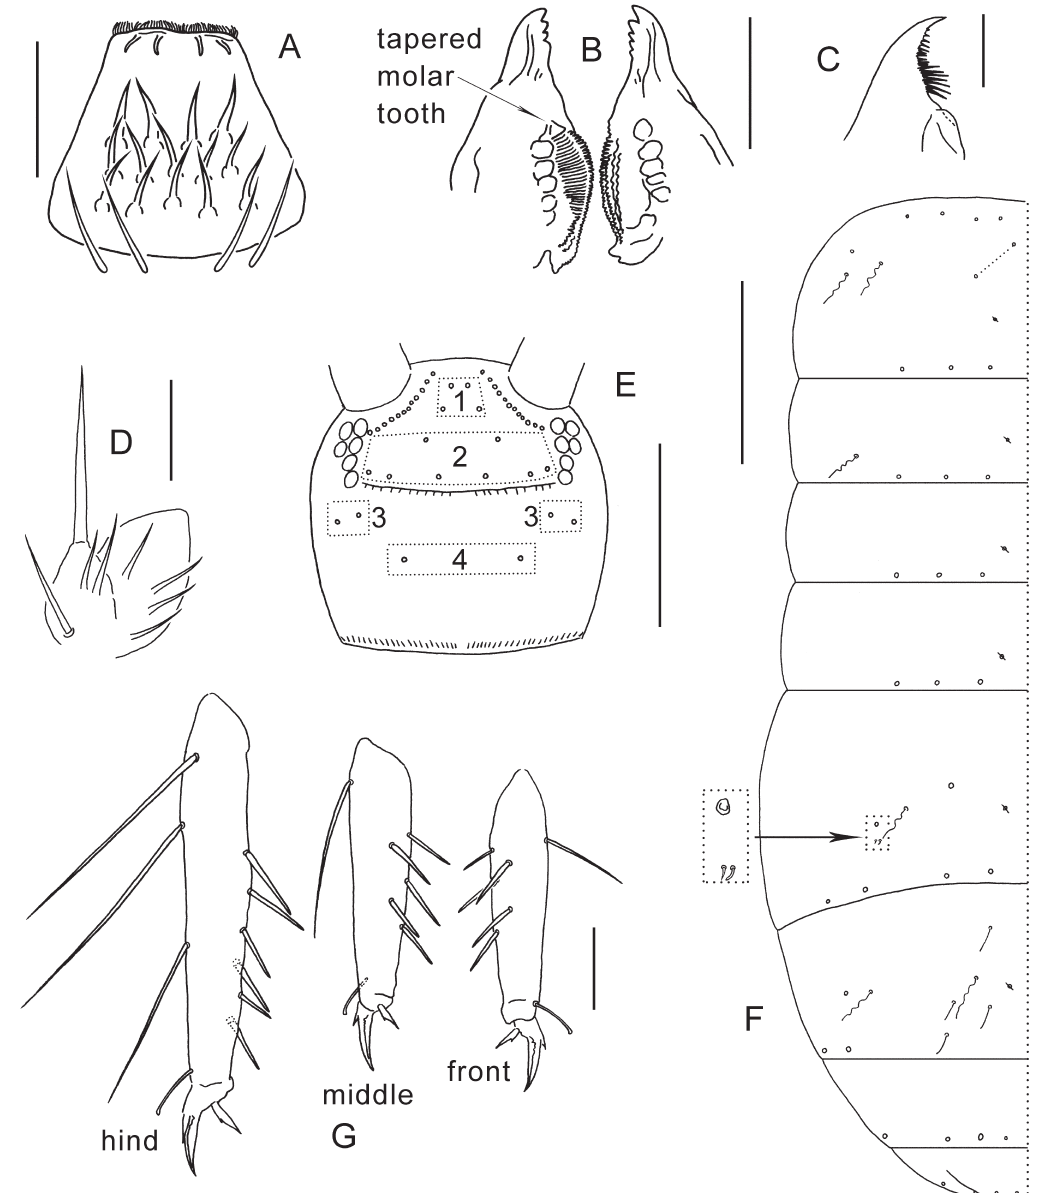
Fig. 2. Tomocerus ocreatus Denis, 1948. A . Labrum (dorsal view). B . Mandibular head (dorsal view). C . Lamella 5 of maxillary head (dorsal view). D . Maxillary outer lobe (ventral view). E . Cephalic dorsal chaetotaxy (circles = sockets of chaetae, same as below; 1 = anterior area; 2 = interocular area; 3 = postocular area; 4 = posterior area). F . Dorsal chaetotaxy of Th. II–Abd. VI (circle with a slash = pseudopore, same as below). G . Right tibiotarsi (lateral view). Scale bars: A, B, G = 100 μm; C = 10 μm; D = 50 μm; E, F = 500